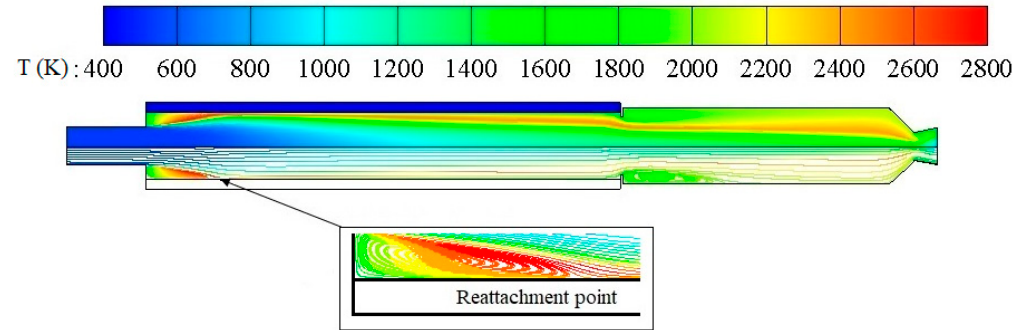
Figure 16. The contour of temperature and streamline.